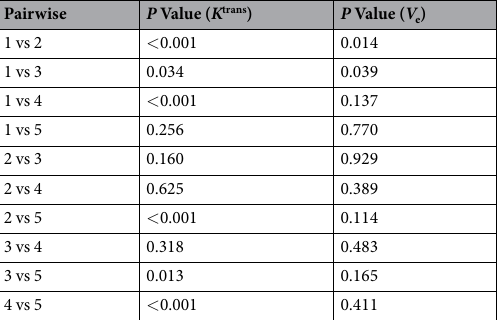
Table 2. Pairwise comparison of DCE-MRI pharmacokinetics of renal tumors. Note: 1: clear cell renal cell carcinoma; 2: papillary renal cell carcinoma; 3: chromophobic renal cell carcinoma; 4: uroepithelial carcinoma; 5: fat-poor angiomyolipoma.